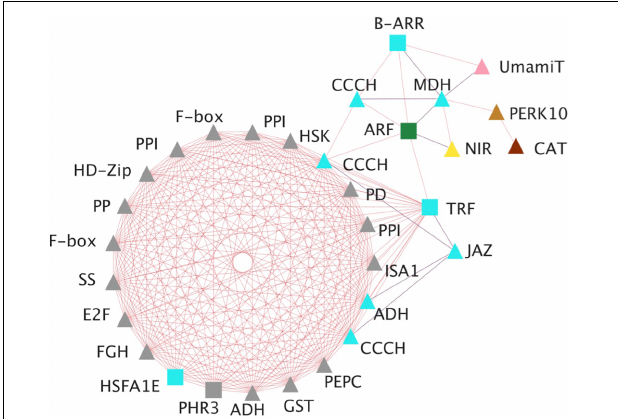
FIGURE 5 | Graphical view of the B-ARR gene co-expression network. Genes included are those encoding: E2F, E2F-like protein; PHR3, protein phosphate starvation response 3; PERK10, proline-rich receptor-like protein kinase; PPI, peptidyl-prolyl cis-trans isomerase; GST, glutathione S-transferase; F-box, F-box/kelch-repeat protein; JAZ, jasmonate ZIM-domain protein; PEPC, phosphoenolpyruvate carboxylase; PP, serine/threonine-protein phosphatase; PD, prephenate dehydrogenase; ADH, alcohol dehydrogenase; HSK, homoserine kinase; FGH, S-formylglutathione hydrolase; MDH, malate dehydrogenase; CCCH, zinc finger CCCH domain; HD-Zip, homeobox-leucine zipper-like protein; RABA1f, ras-related protein; ISA1, isoamylase 1; NIR, ferredoxin–nitrite reductase; HSFA1E, heat stress TF A-1e; GST, glutathione S-transferase; ARF, auxin response factor; CAT, cationic amino acid transporter, usually multiple amino acids move in and out transporter (UMAMIT), starch synthase (SS) and telomeric repeat binding protein (TRF). Cytoscape version 3.9.1 platform was used to visualize the network (Shannon et al., 2003). Square symbols mean TF, triangles mean no-TF, blue edges indicate negative associations and red edges indicate positive associations. Color inside each node means the co-expression module where the gene is included. Gray symbols represent genes that in the B-ARR interaction network are only expressed in the cotyledonary stage (C) of the zygotic embryos.